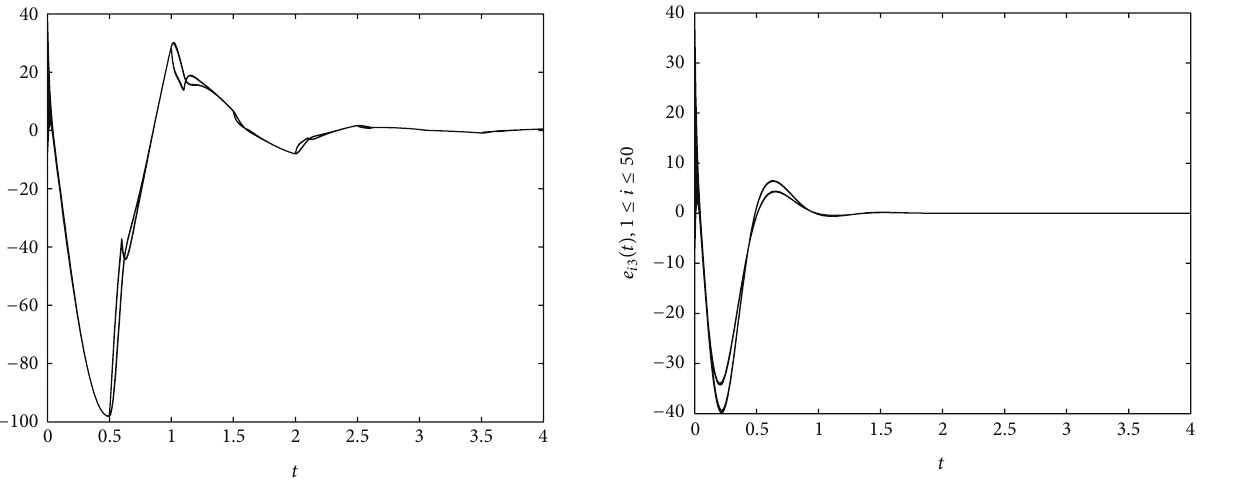
Figure 13: Synchronization errors 𝑒 𝑖 3 , 1 ≤ 𝑖 ≤ 50, with full control parameters 𝑘 = 5, 𝑇 = 0 . 5, and 𝜃 =